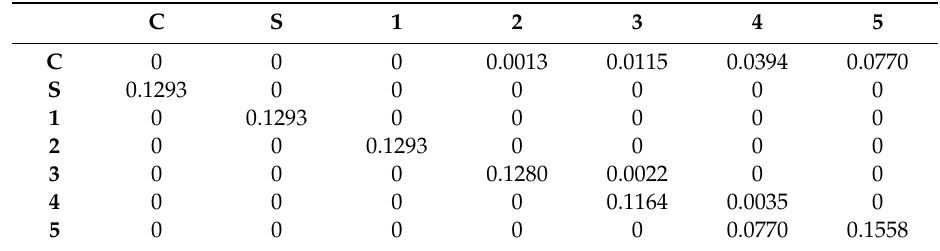
Table 6. Elasticity analysis for a Monterey pine matrix projection model in the absence of pitch canker disease with classes corresponding to cones (C), seeds (S), seedlings (1), small saplings (2), medium saplings (3), large saplings (4), and mature trees